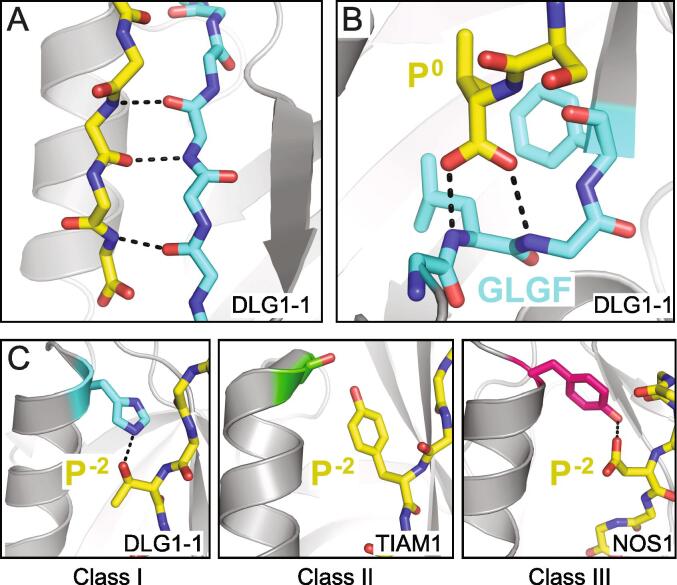
Conserved structural features of PDZ binding interactions. (A) The Dlg1 PDZ1 (DLG1-1) domain is in gray cartoon, with the exception of the βB strand (stick figure; cyan carbon atoms and heteroatoms colored by type). The APC peptide ligand is also shown as a stick figure (yellow carbon atoms). The peptide forms an additional strand of the core antiparallel β-sheet. Hydrogen bonds are shown as dashed lines, with distances (from bottom-to-top) of 2.7 Å, 3.0 Å, and 3.0 Å. (B) The carboxylate moiety of the P0 residue in APC interacts directly with the amides of the DLG1-1 “GLGF” motif (stick model; cyan carbon atoms). Hydrogen bond (dashed lines) are shown, with lengths from left-to-right of 2.9 Å and 3.3 Å. (C) Interactions of the PDZ domain with the P−2 residue historically determine binding class, and conserved features are shown for Classes I (DLG1-1, hydrogen bond, 3.0 Å), II (TIAM1, interacting residue in green sticks colored by heteroatom), and III (NOS, interacting residue in pink sticks colored by heteroatom; hydrogen bond, 2.9 Å) PDZ domains. PDB codes are: DLG1-1 (3RL7), TIAM1 (3KZE), NOS1 (1B8Q). For all, heteroatoms are colored by atom type (O = red and N = blue). (For interpretation of the references to colour in this figure legend, the reader is referred to the web version of this article.)